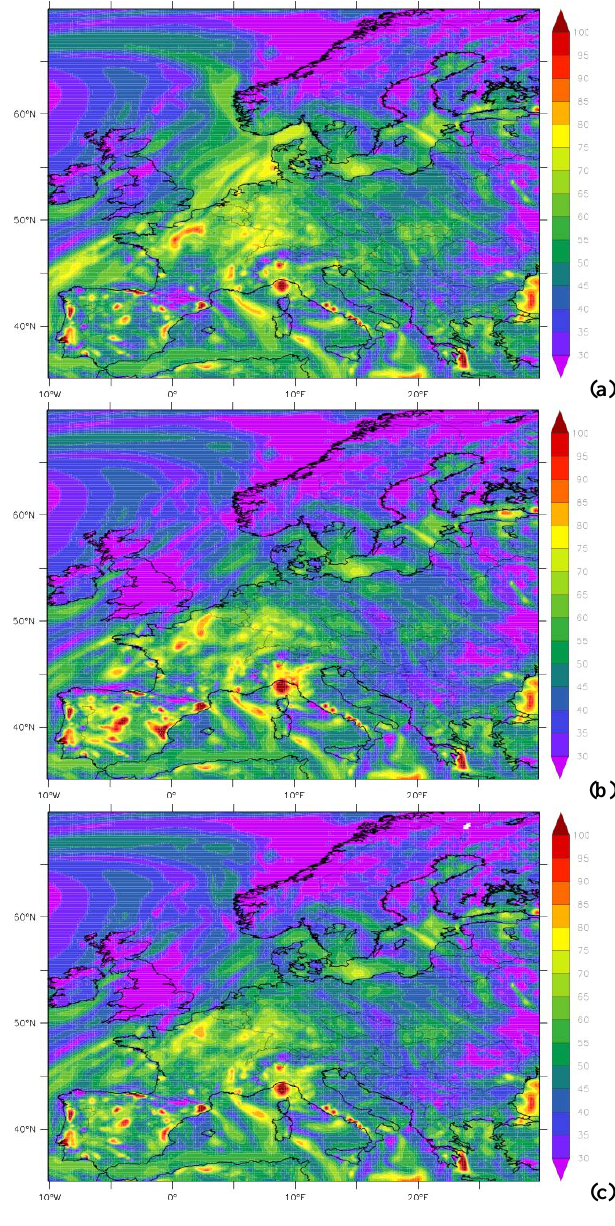
Fig. 9. Surface ozone concentration (in ppb) on the 7 July 2010 at 14:00:00 UTC for the (a) D IRECT simulation, (b) P ERCENT simu- lation, (c) O PER simulation, see Table 1 for details on the experi-